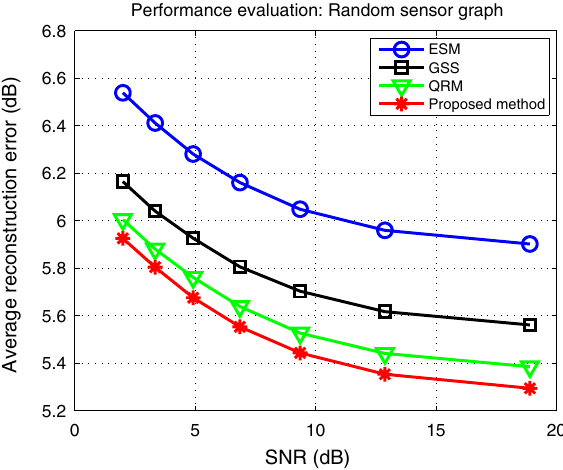
Fig. 7 Performance evaluation for noisy non‑bandlimited graph signals on RSG with | S | = 50 by varying